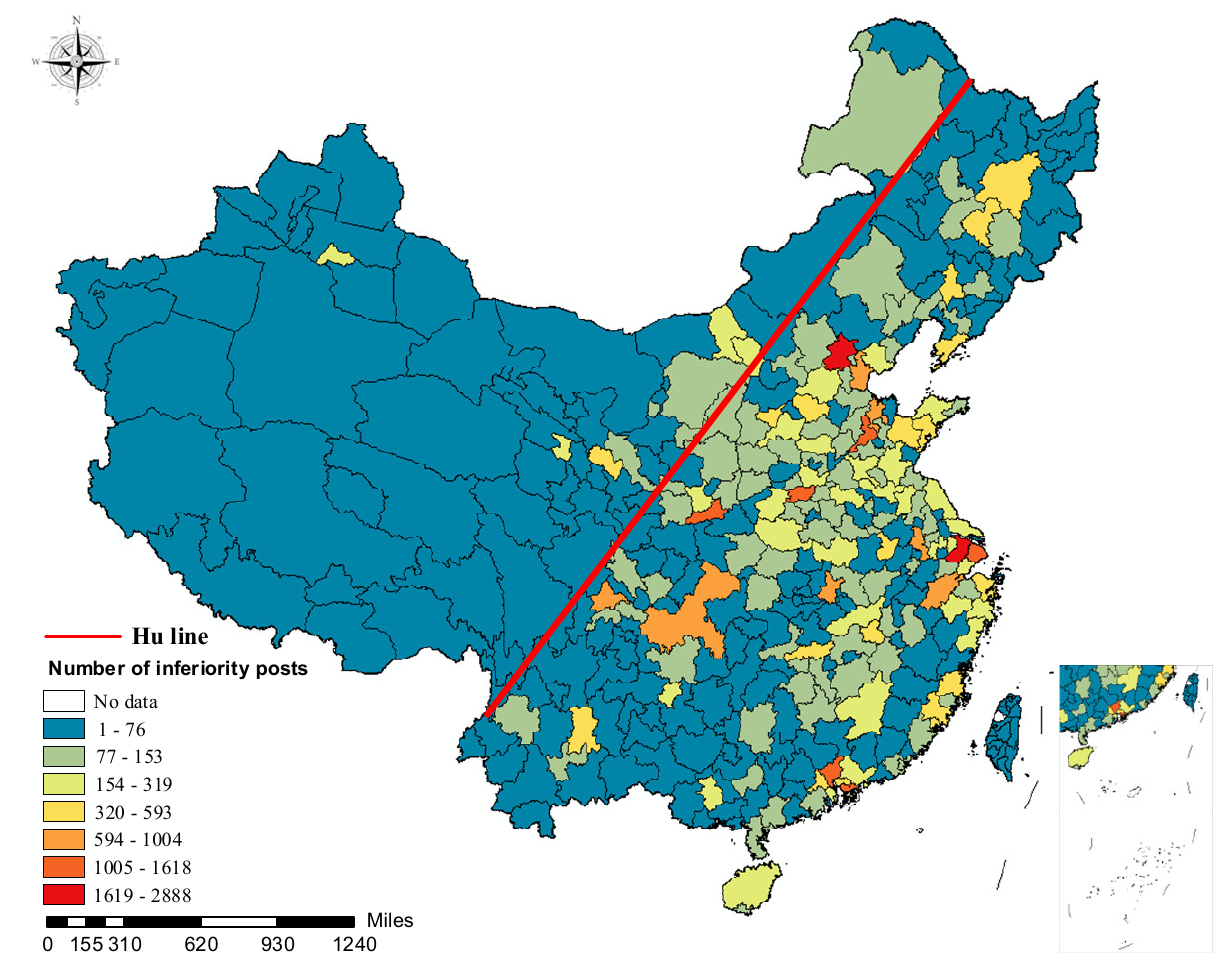
Figure 1. Distribution of total inferiority posts of cities in China. (Note: Natural breaks were used to classify posts from Weibo.)